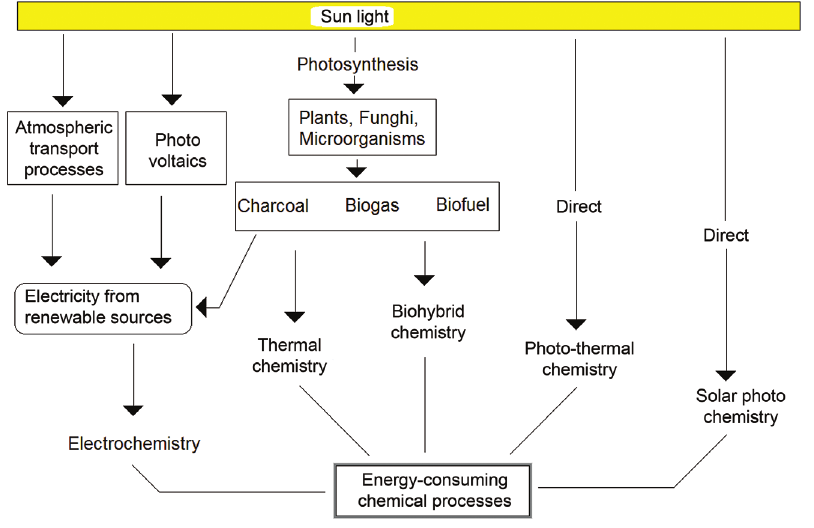
Figure 5 Application of renewable energy sources in energy-consuming chemical